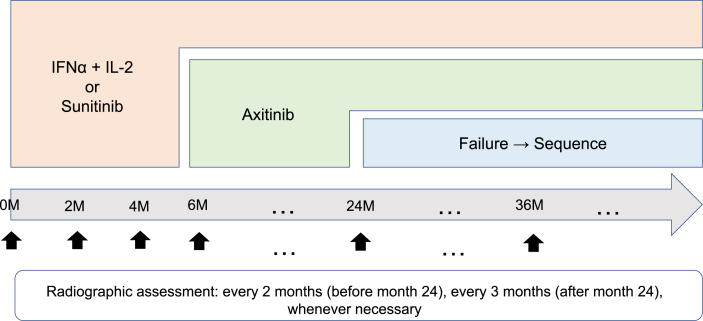
Follow-up schedule.